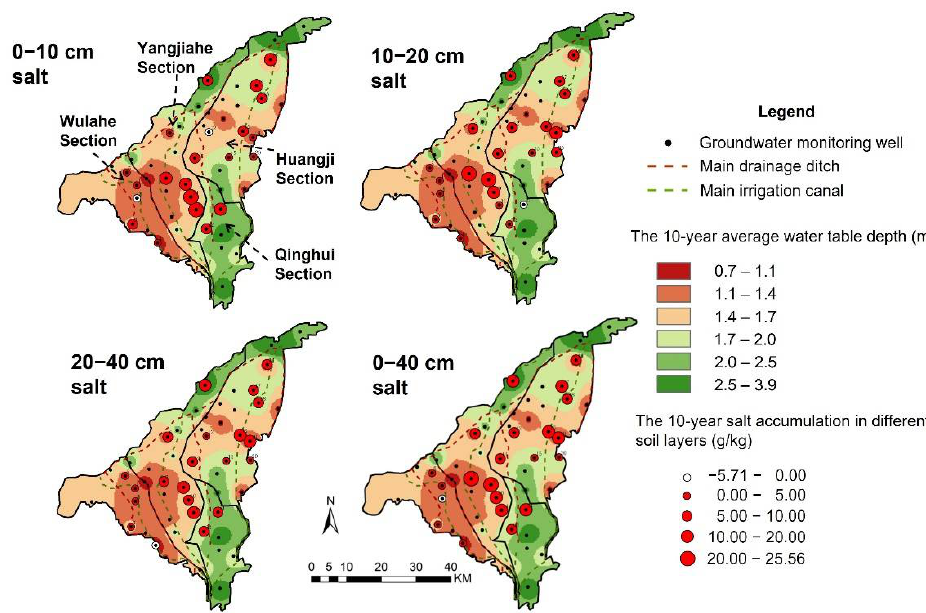
Figure 6. The 10-year cropping season salt accumulation in different layers of the 22 soil sampling sites and the 10-year cropping season average water table depth in the Jiefangzha Subdistrict (JFZSD).